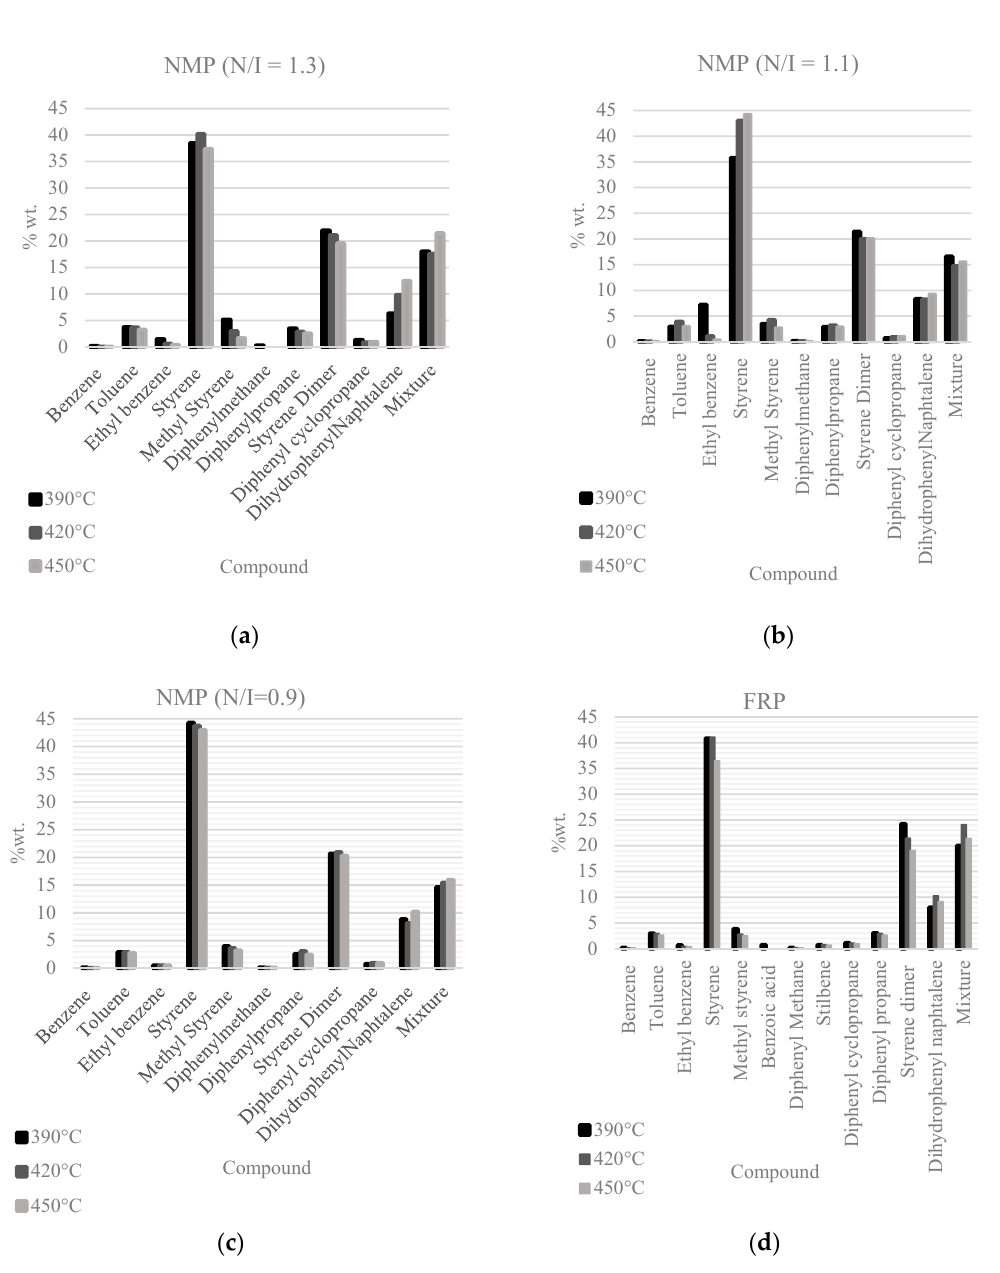
Figure 3. Yields of recovered fractions of the pyrolyzed samples: ( a ) N/I = 1.3, ( b ) N/I = 1.1, ( c ) N/I = 0.9, and ( d ) FRP.